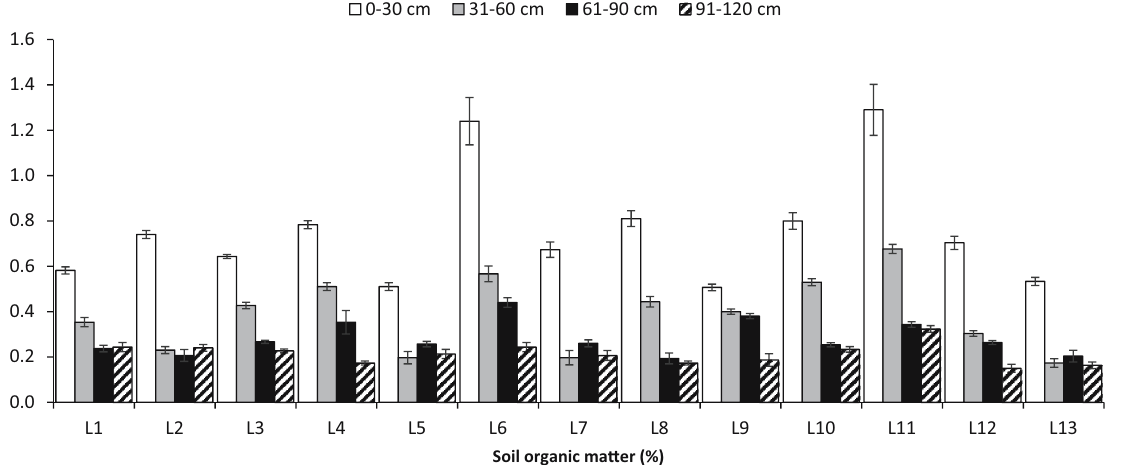
020406080100120